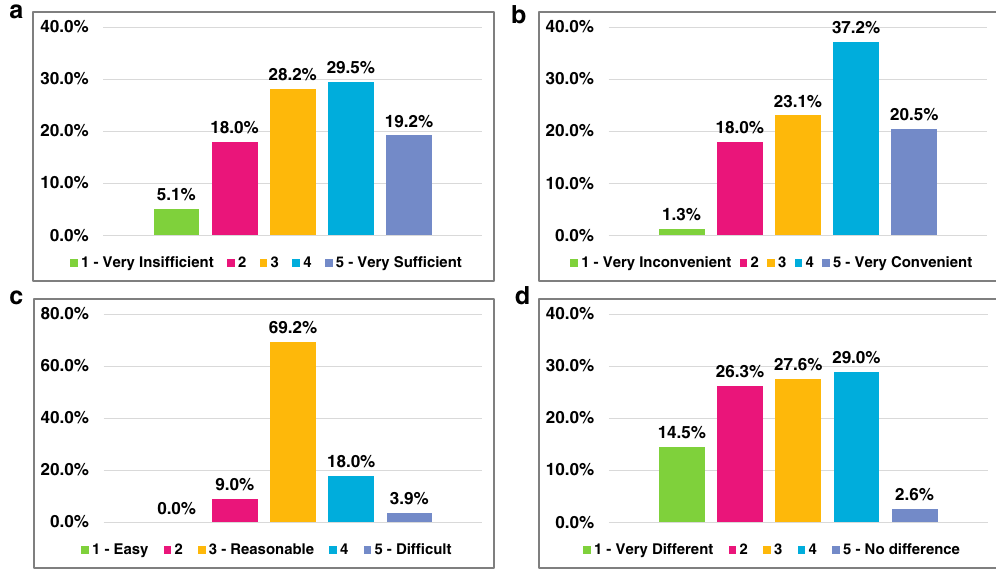
Fig. 3 Post-exam online survey results. Bar graph summary in terms of a suf fi ciency of time slot length, b convenience of platform interface, c easiness of exam questions, and d similarity to other online exams respectively (performed on 28 April 2020 for the undergraduate medical imaging course offered at Rensselaer Polytechnic Institute, Troy, New York,